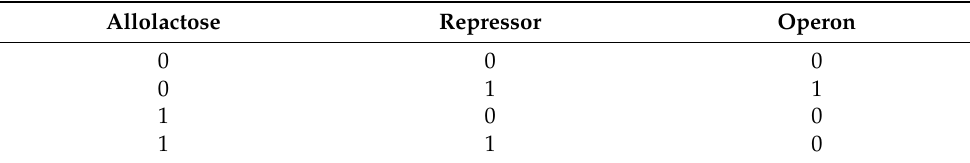
Table 2. Lac operon as a Boolean “if…then…” operator. Allolactose